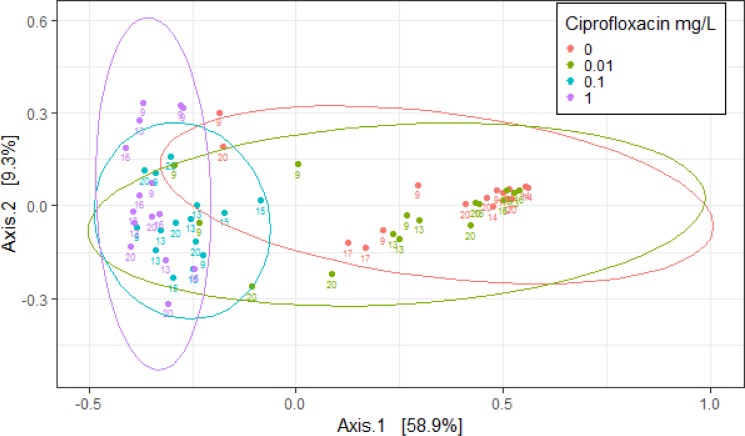
Principle Coordinate Analysis (PCoA) based on Bray Curtis dissimilarity metrics, showing the distance in the bacterial communities between the treatments.